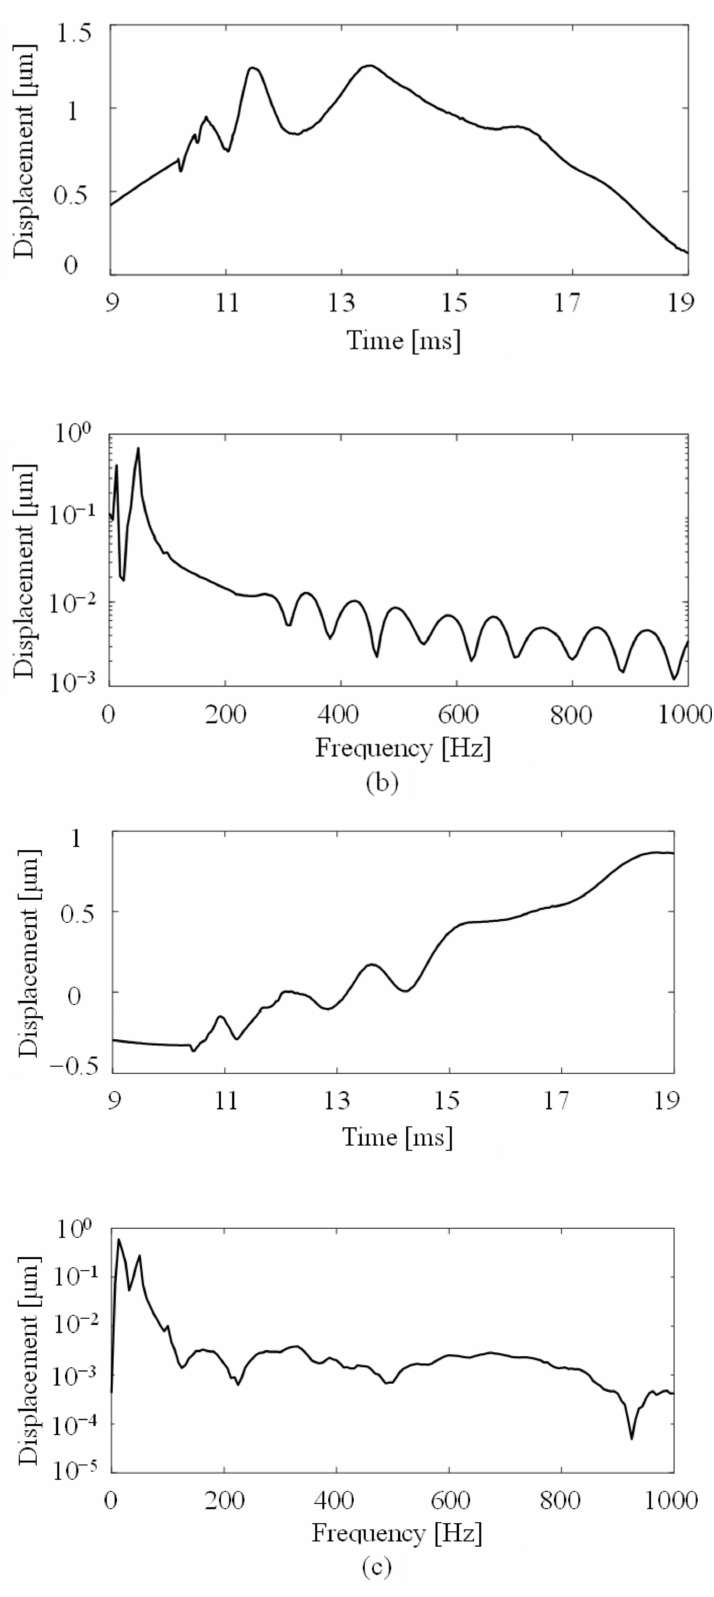
Figure 3. Time history responses and Fourier spectra of the measured displacement on mango 6 at ( a ) point 1, ( b ) point 12, and ( c ) point 24. (Measurement path: Line